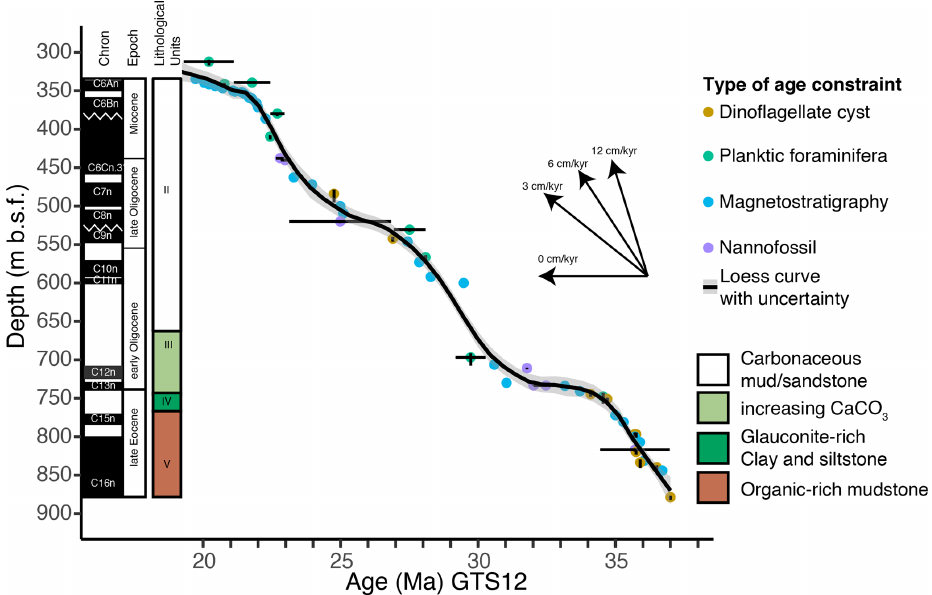
Figure 2. Age–depth model of ODP Site 1168, based on magneto- and biostratigraphy (calcareous nannofossils, planktic foraminifera, diatoms and dinocysts) after Stickley et al. (2004b), here recalibrated to GTS2012 of Gradstein et al. (2012) (Table S1 in the Supplement). A smoothed line is drawn through the age constraints using the loess smoothing method with a span of 0.1. Lithological units are indicated to the right of the palaeomagnetic chrons and the indication of epochs (Exon et al., 2001b). The arrows indicate the sedimentation